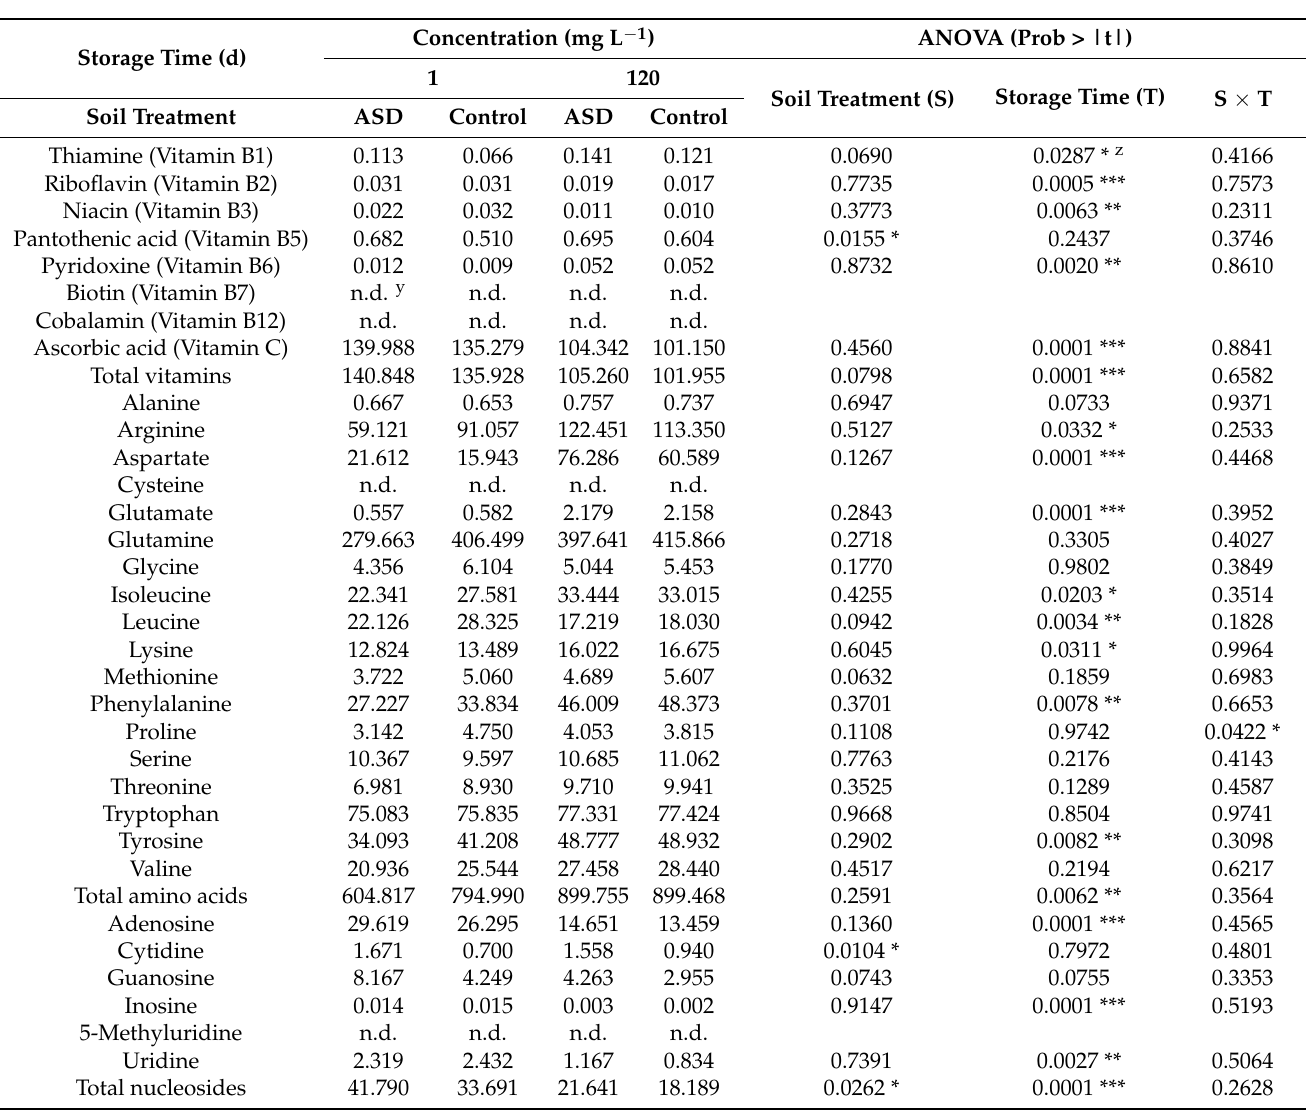
Table 4. Effect of soil treatment and storage time on vitamins, amino acids and nucleosides of winter melon juice